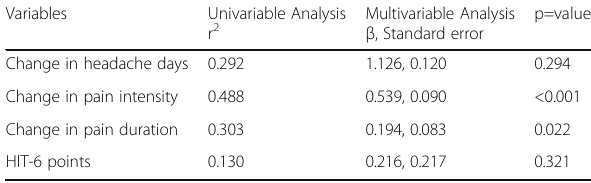
Table 1 (abstract O25). Results of univariate and multivariate analysis